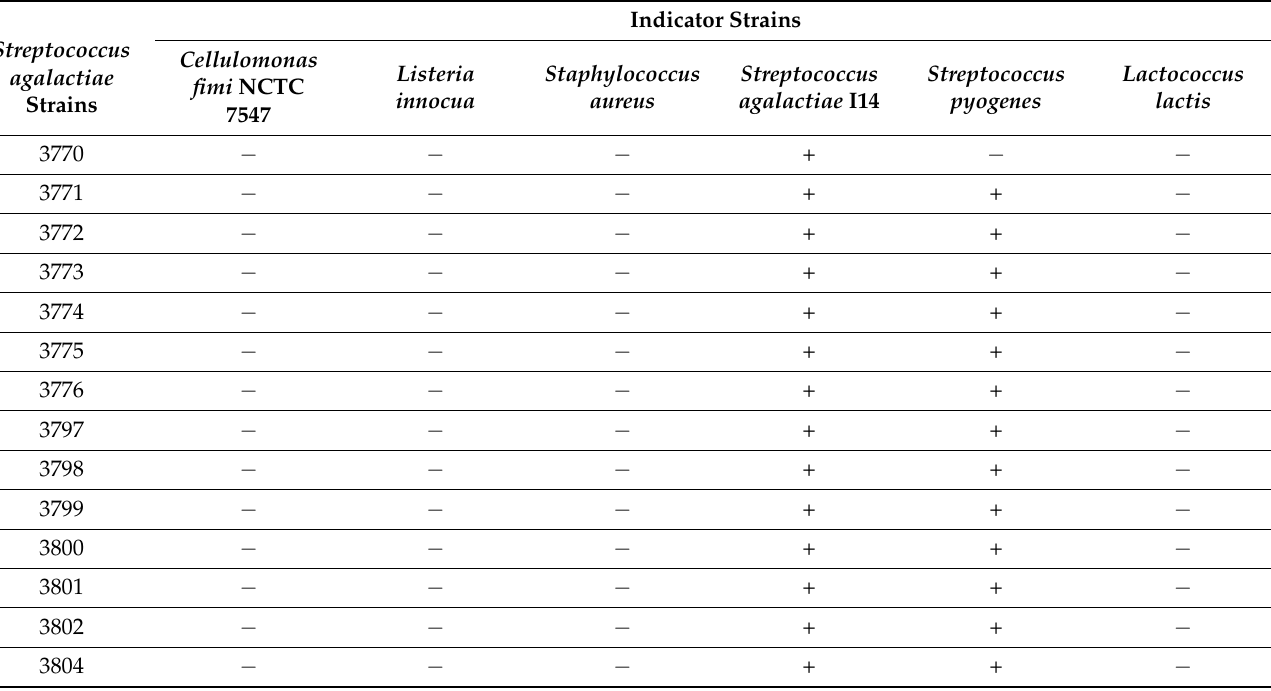
Table 5. Deferred growth inhibition assays results. Only displayed in the table are the Streptococcus agalactiae strains that inhibited at least one of the indicator strains. (+) indicates clear inhibition zones of at least 2 mm in size; ( − ) indicates absence of